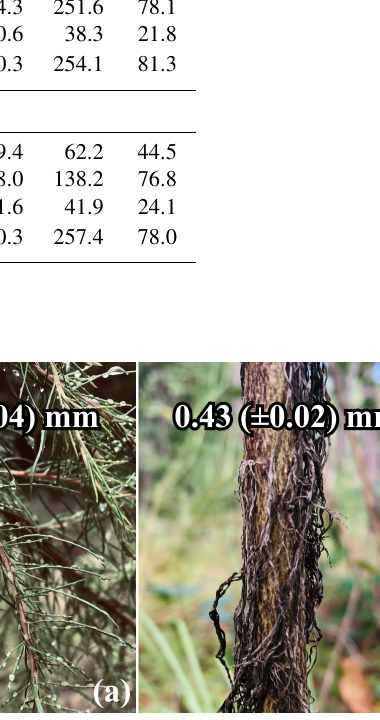
Figure 4. Water storage capacity (standard error) for the (a) canopy and (b) stem of Eupatorium capillifolium (dogfennel) per lab-based submersion tests on samples collected from the Charles H. Herty Pines Nature Preserve